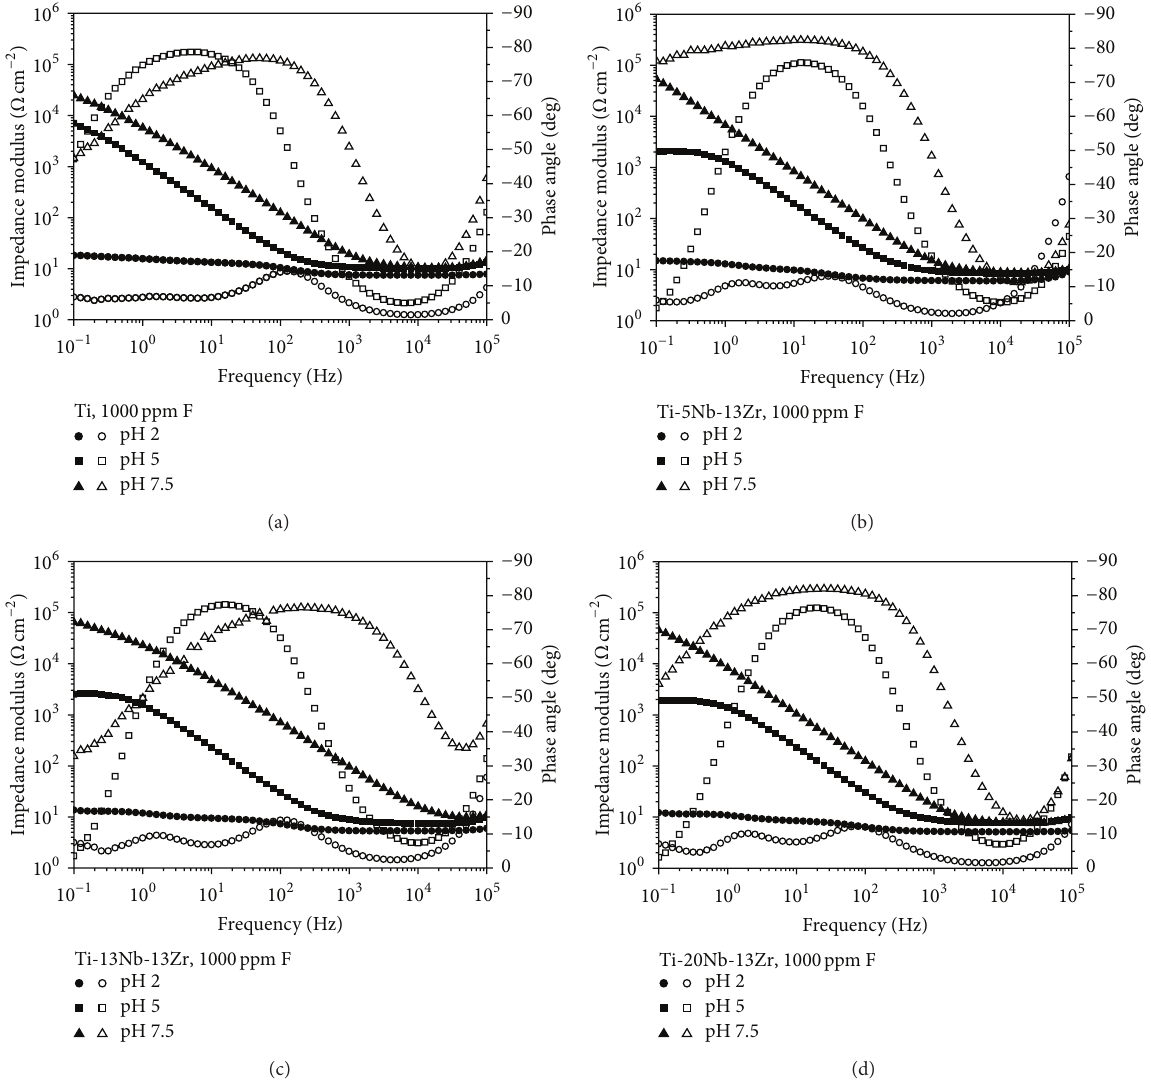
Figure 8: Bode diagrams of (a) CP-Ti, (b) Ti-5Nb-13Zr, (c) Ti-13Nb-13Zr, and (d) Ti-20Nb-13Zr obtained at OCP in Ringer’s solution of pH 2, 5, and 7.5 containing 1000 ppm F at 37 ∘